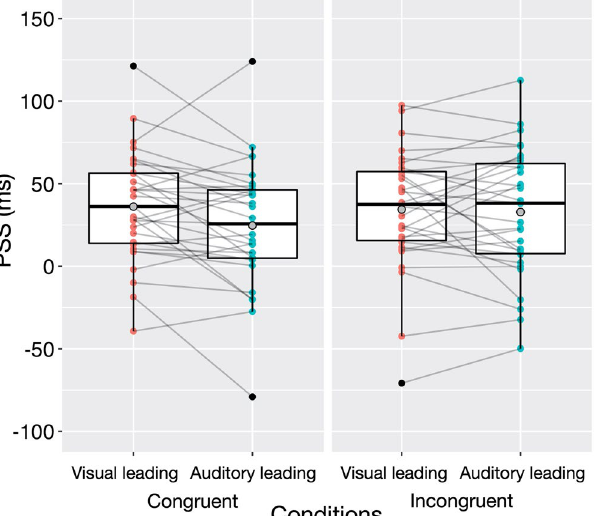
Figure 4. PSS data as a function of test stimulus condition (congruent or incongruent) and adaptation condition (visual leading or auditory leading) in Experiment